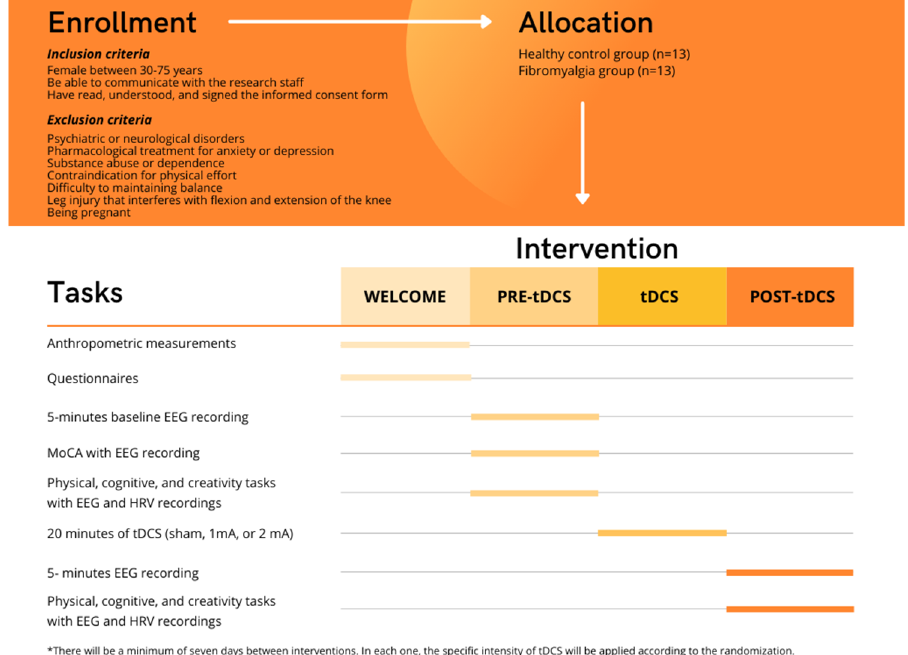
Figure 1. Timeline of the